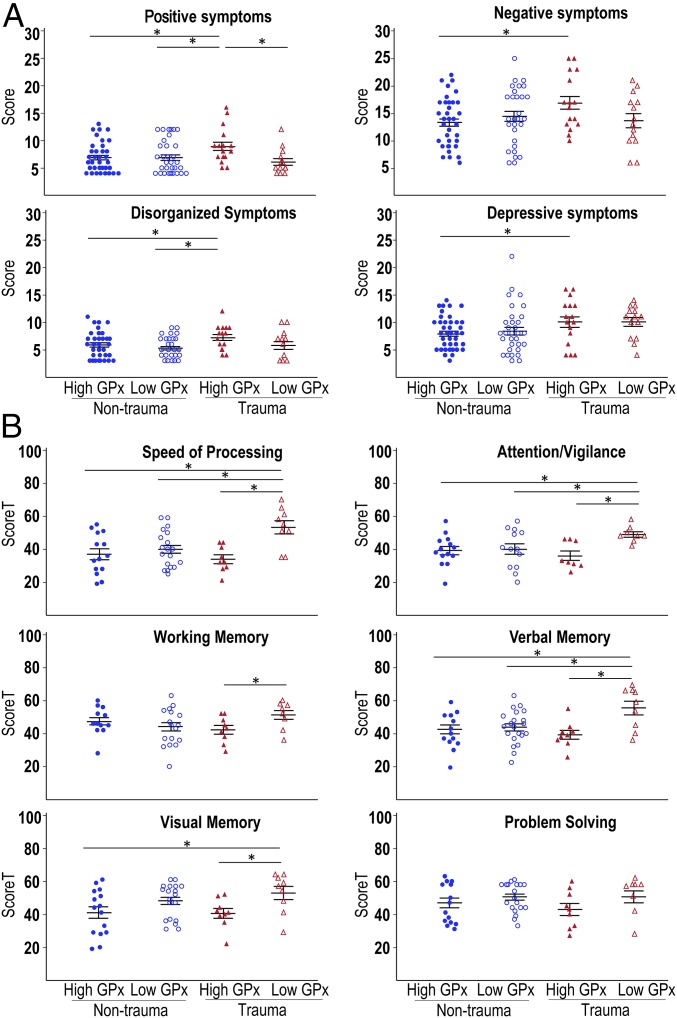
Psychopathological and neurocognitive profiles. (A) Symptoms were evaluated using the Positive and Negative Syndrome Scale in high- and low-GPx EPP−NT and high- and low-GPx EPP+CT. Dot plots illustrate individual scores, group mean, and SD for four subscales of the Wallwork et al. (51) five-factor model. (B) Neurocognition was assessed using the MATRICS Consensus Cognitive Battery. Dot plots illustrate individual standardized t scores, group mean, and SD for the six factors evaluated. *P < 0.05.